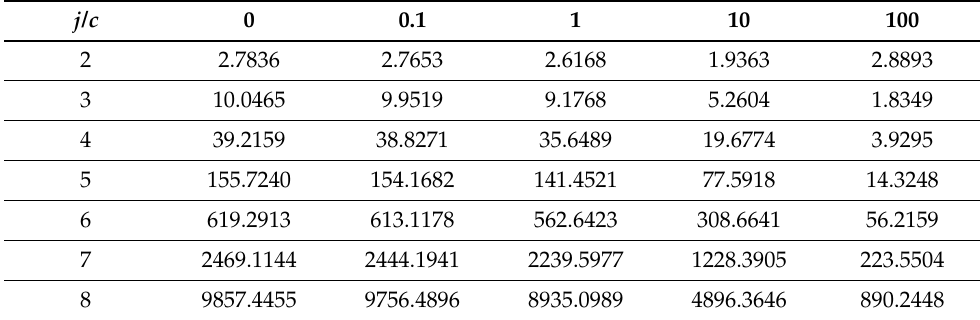
Table 1. Condition numbers of the stiffness matrix A j .